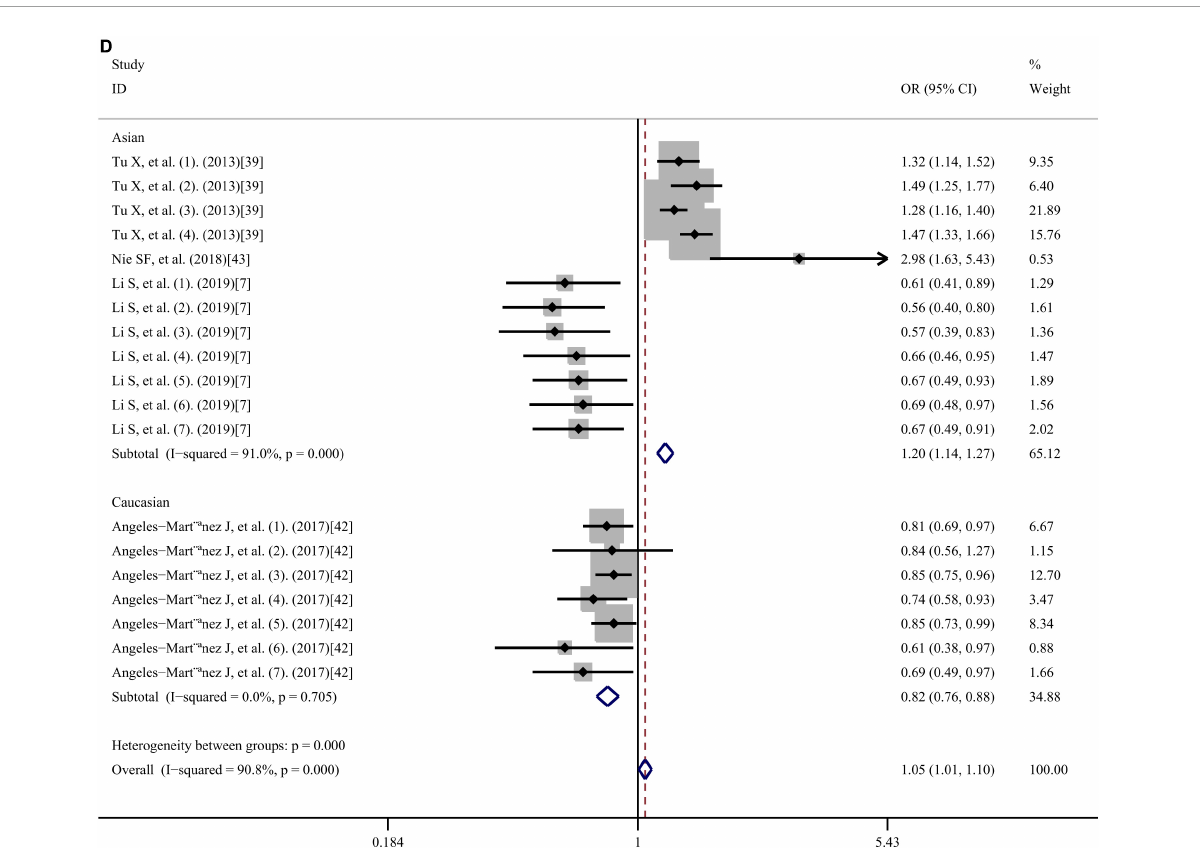
FIGURE7 Subgroup analyses based on (A) genes, (B) single nucleotide polymorphisms, (C) genotyping methods, and (D) ethnicity. OR, odds ratio; CI, confidence interval.